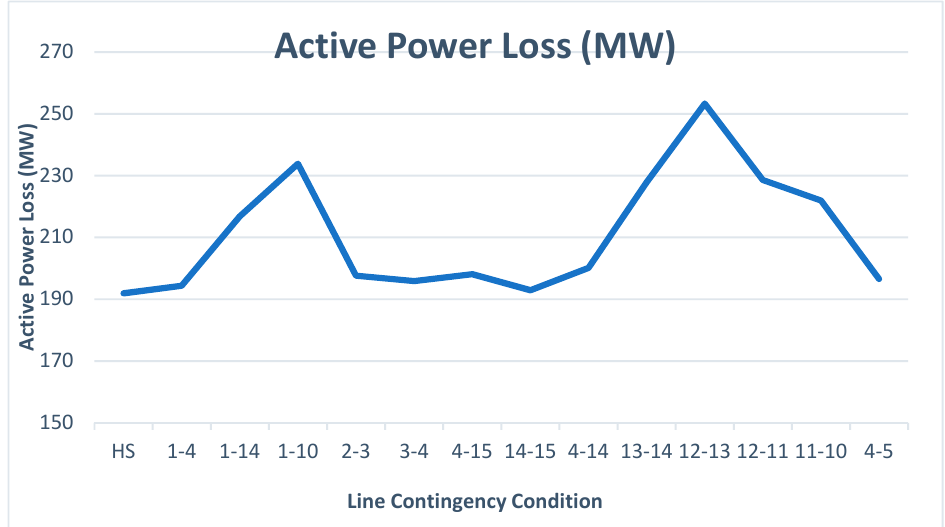
Figure 4. Active Power Loss in various line contingencies. HS = Healthy System. Table 2. Line Severity Index of transmission lines connected to load buses for line 12–13 contingency condition.